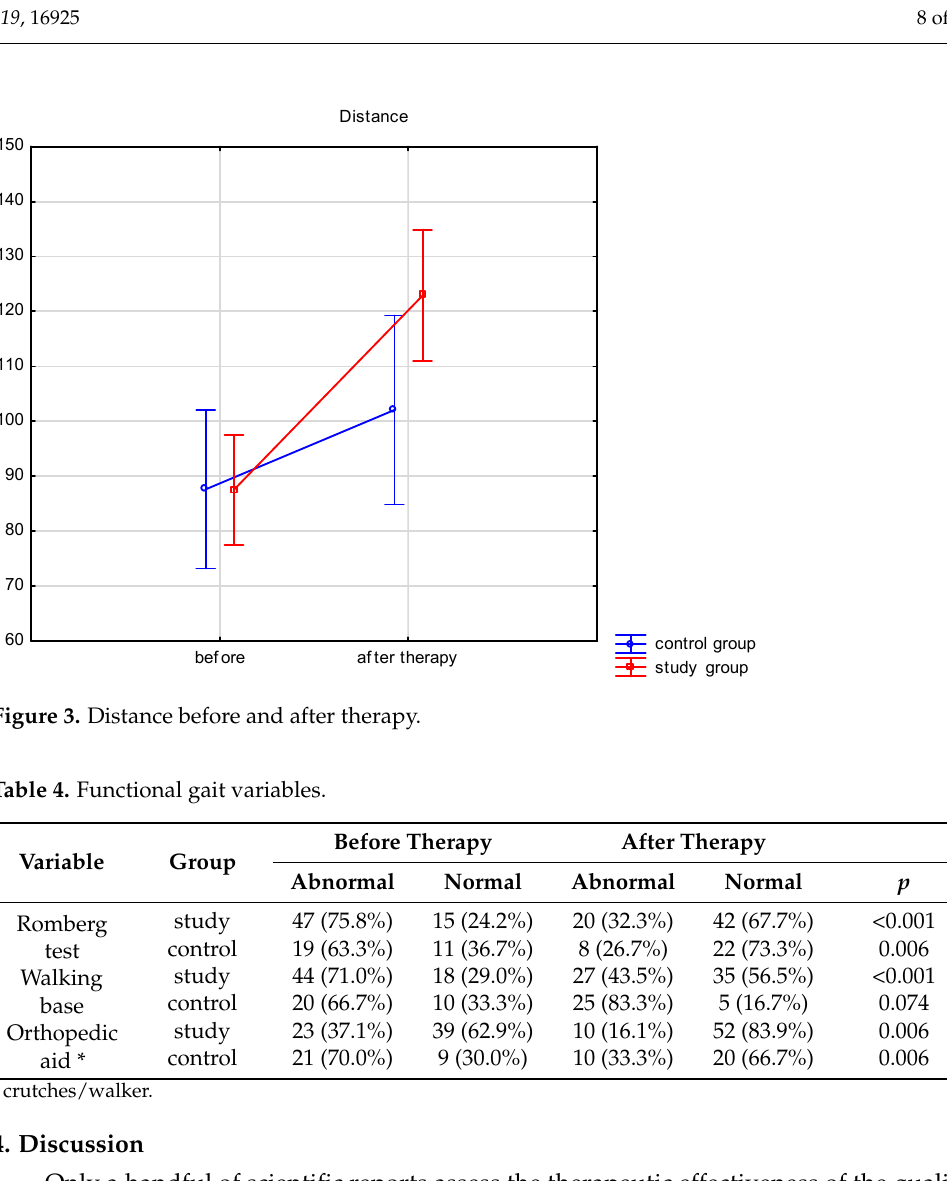
Figure 2. Walking speed before and after therapy.